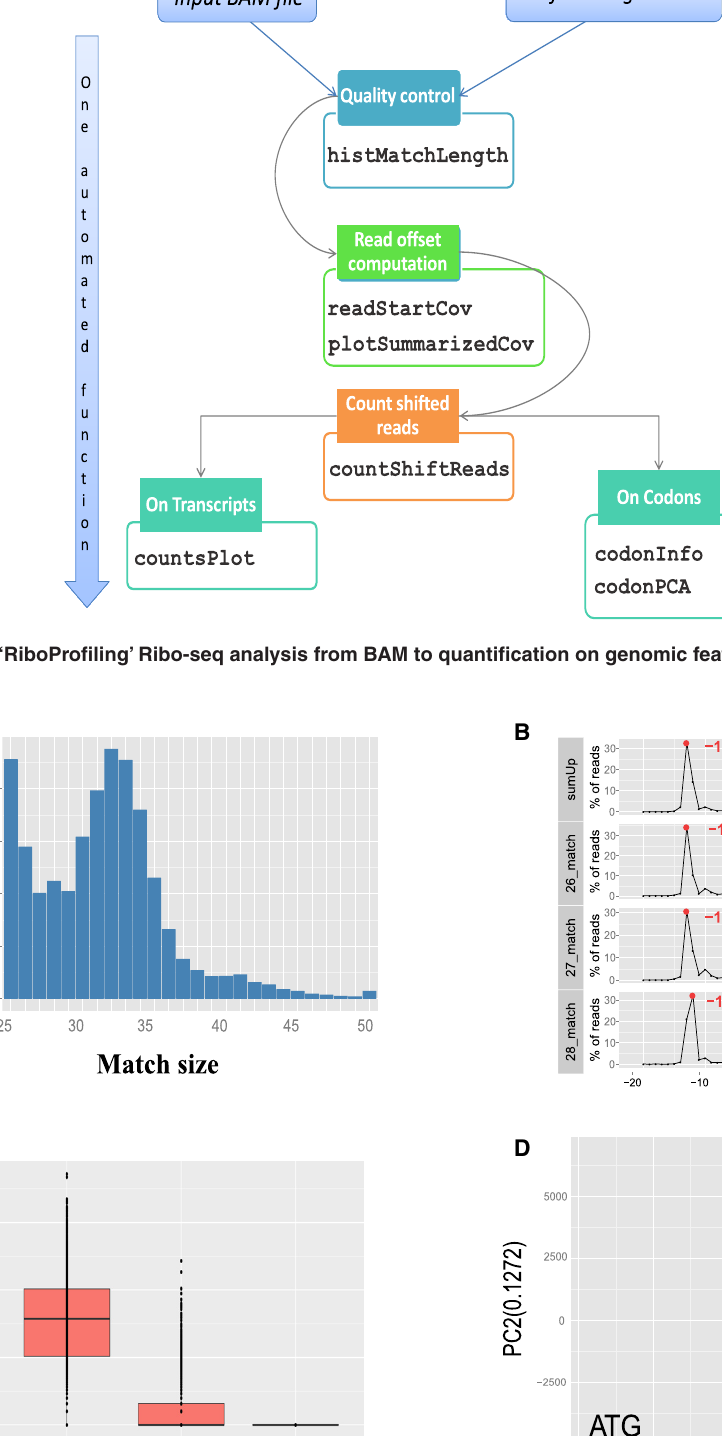
Figure 2. Graphical output of ‘RiboProfiling’ package on the G�M1������� dataset. A‘RiboProfiling’ package on the G�M1������� dataset. ARiboProfiling’ package on the G�M1������� dataset. A , Histogram of read length distribution with ‘hist�at�h�ength�� fun�tion��hist�at�h�ength�� fun�tion�� B , Frequen�y of reads around the TSS for reads sizes 26 to 28; this graph points to an offset of 13 bp between the read 5�� end and the ribosome P-site�� C , Boxplots of Ribo-seq read �overage on the CDS, 5�� UTR and 3�� UTR regions of protein �oding genes�� D �� PCA analysis of Ribo-seq �overage on �odons��